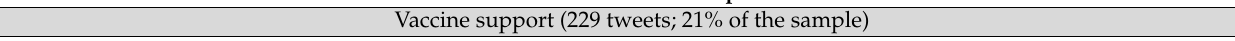
Table 1. Content analysis themes of tweets related to COVID-19 vaccines and race/ethnicity with illustrative examples, from sample of 1110 tweets from October 2020 to January 2021.